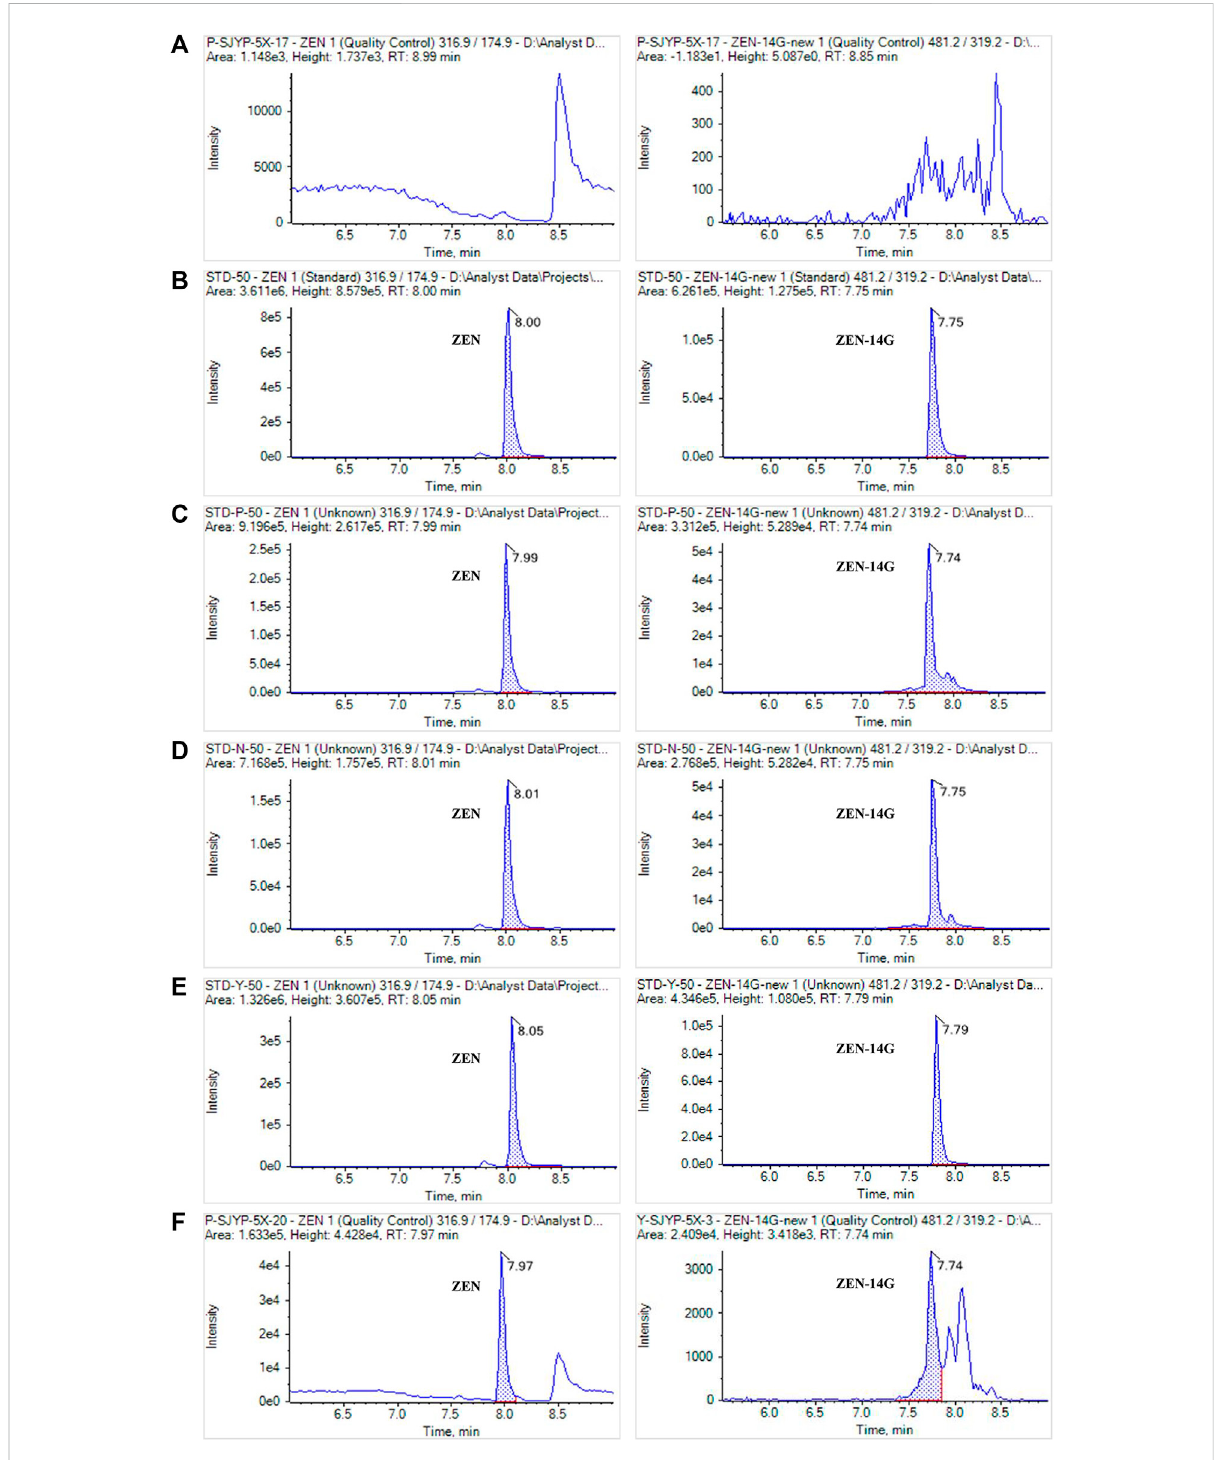
FIGURE 4 MRM chromatograms of ZEN and ZEN-14G in a blank feed sample (A) , in the neat solvent standard solution (B) , in the formula feed matrix standard solution (C) , in the concentrated feed matrix standard solution (D) , in the premixed feed matrix standard solution (E) , and in real contaminated feed samples (F) . The concentrations of standard solutions were 50 ng ml − 1 for ZEN and